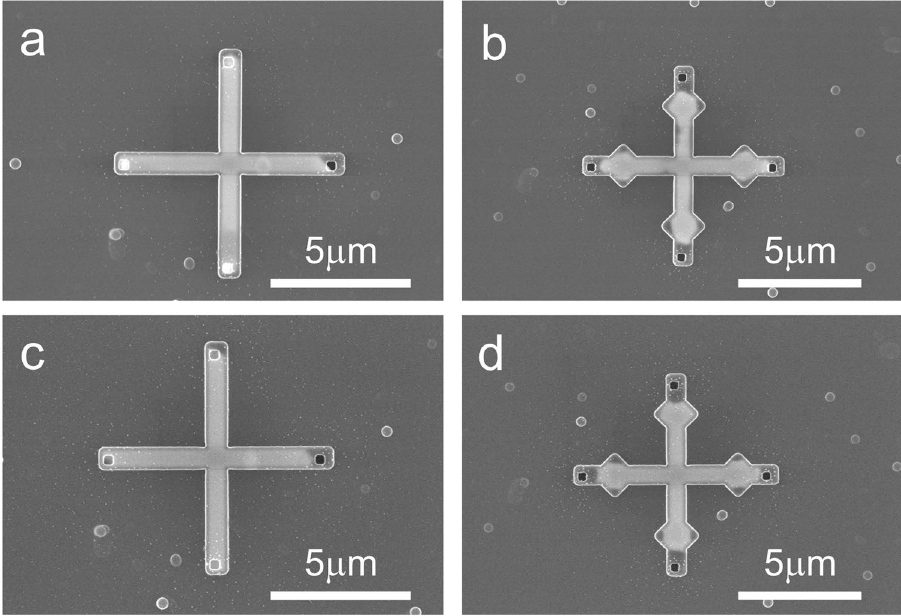
Fig. 2 Top-view SEM images of electrodeposited indium inside 300 nm thick templates. Each template has four inlet openings and one (hidden) seed contact to the wafer. a The straight legs fill uni- formly, while gaps can form at recessed corners b . c , d The same structures as in ( a , b ) after melting and solidifica- tion. The spherical